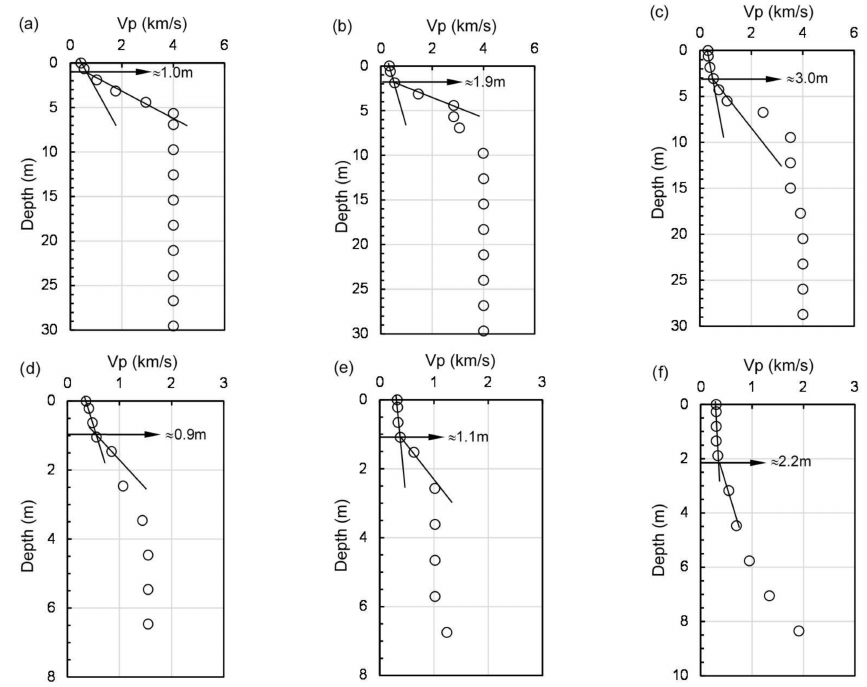
Figure 8. Estimated soil depth profile based on graphical bilinear method: ( a ) 30 m of BTS; ( b ) 80 m of BTS; ( c ) 100 m of BTS; ( d ) 20 m of BS; ( e ) 30 m of MS; and ( f ) 20 m of